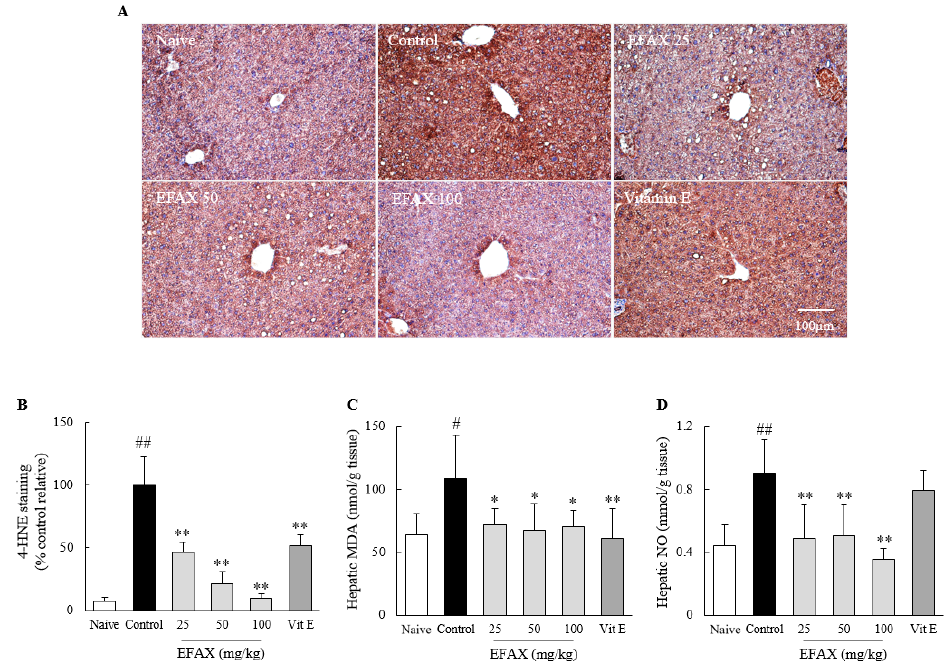
Figure 6. E ff ects on hepatic oxidative stress. Mice ( n = 8 in each group) were fed a 60% high-fat diet for 8 weeks, excluding the naive group (normal chow diet). From the 3rd week of high-fat diet feeding, distilled water (control), EFAX (25 mg / kg, 50 mg / kg, 100 mg / kg), and vitamin E (100 mg / kg) were administered by gavage daily for the last 6 weeks. 4-hydroxynonenal (4-HNE) staining ( A ) of liver sections was performed, and representative photographs (200 × magnification) were semi-quantified ( B ). Hepatic levels of malondialdehyde (MDA) ( C ) and Nitric Oxide (NO) ( D ) were evaluated. # p < 0.05, ## p < 0.01 compared with the naive group; * p < 0.05, ** p < 0.01 compared with the control group.